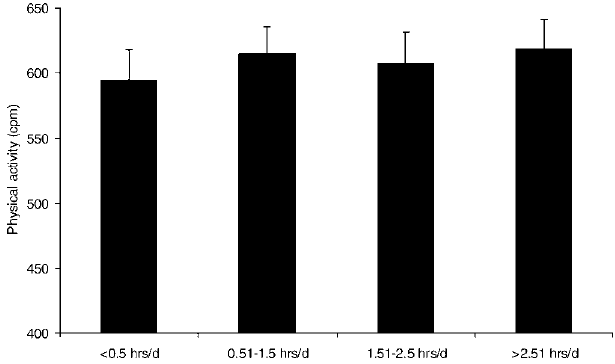
Figure 1. Objectively Measured PA (Mean 95% Confidence Interval [CI]) Stratified by Quartiles of TV Viewing ( n ¼ 1,702) Data are adjusted for gender, study location, age group, sexual maturity, smoking status, and parental